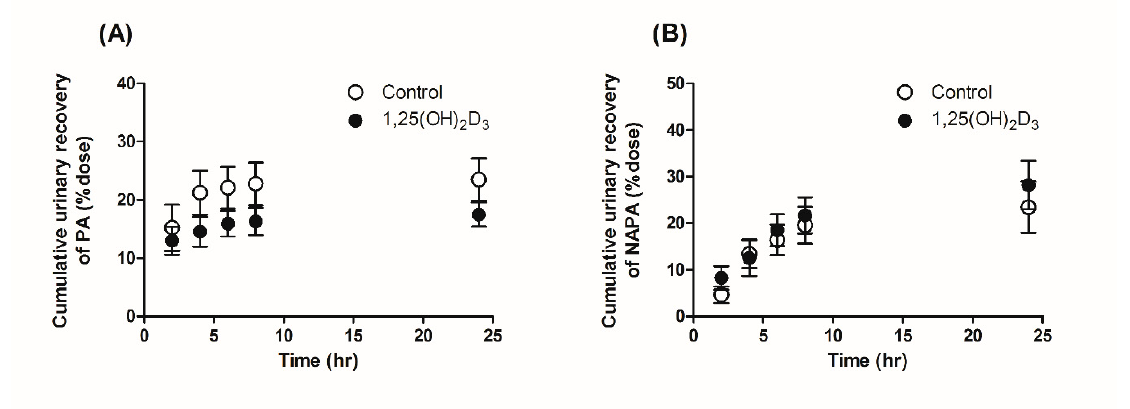
Figure 4. Mean cumulative urinary recovery of ( A ) PA and ( B ) NAPA following intravenous administration of 10 mg/kg PA HCl to control (open circles, n = 9) and 1,25(OH) 2 D 3 -treated rats (closed circles, n = 7).